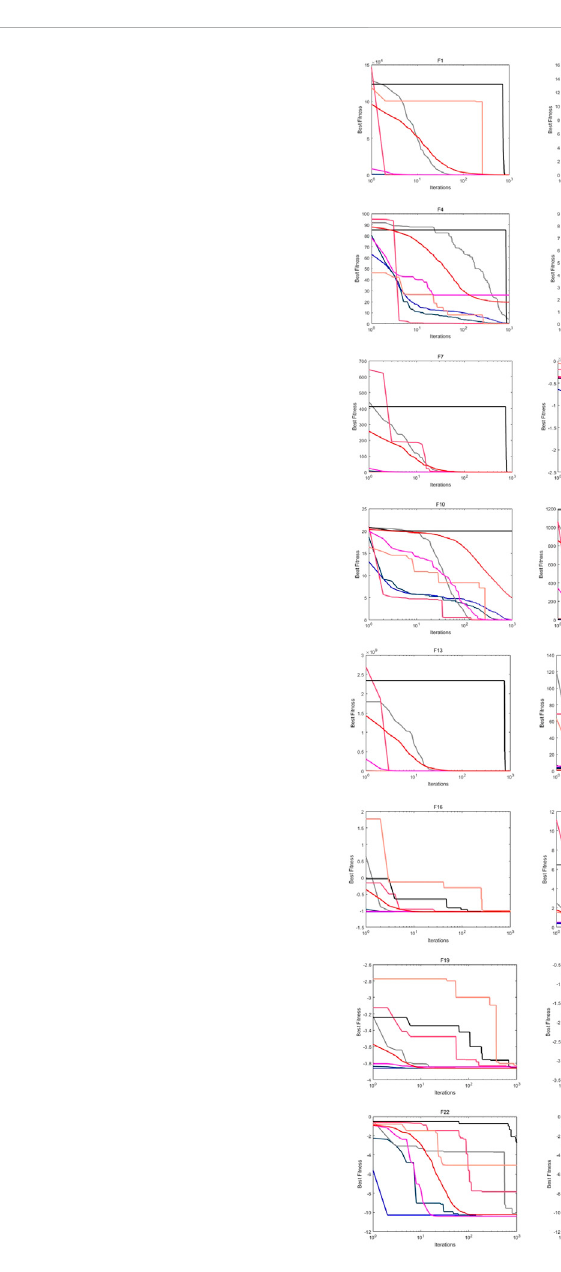
FIGURE 2 The convergence behavior of the compared methods with 23 CEC